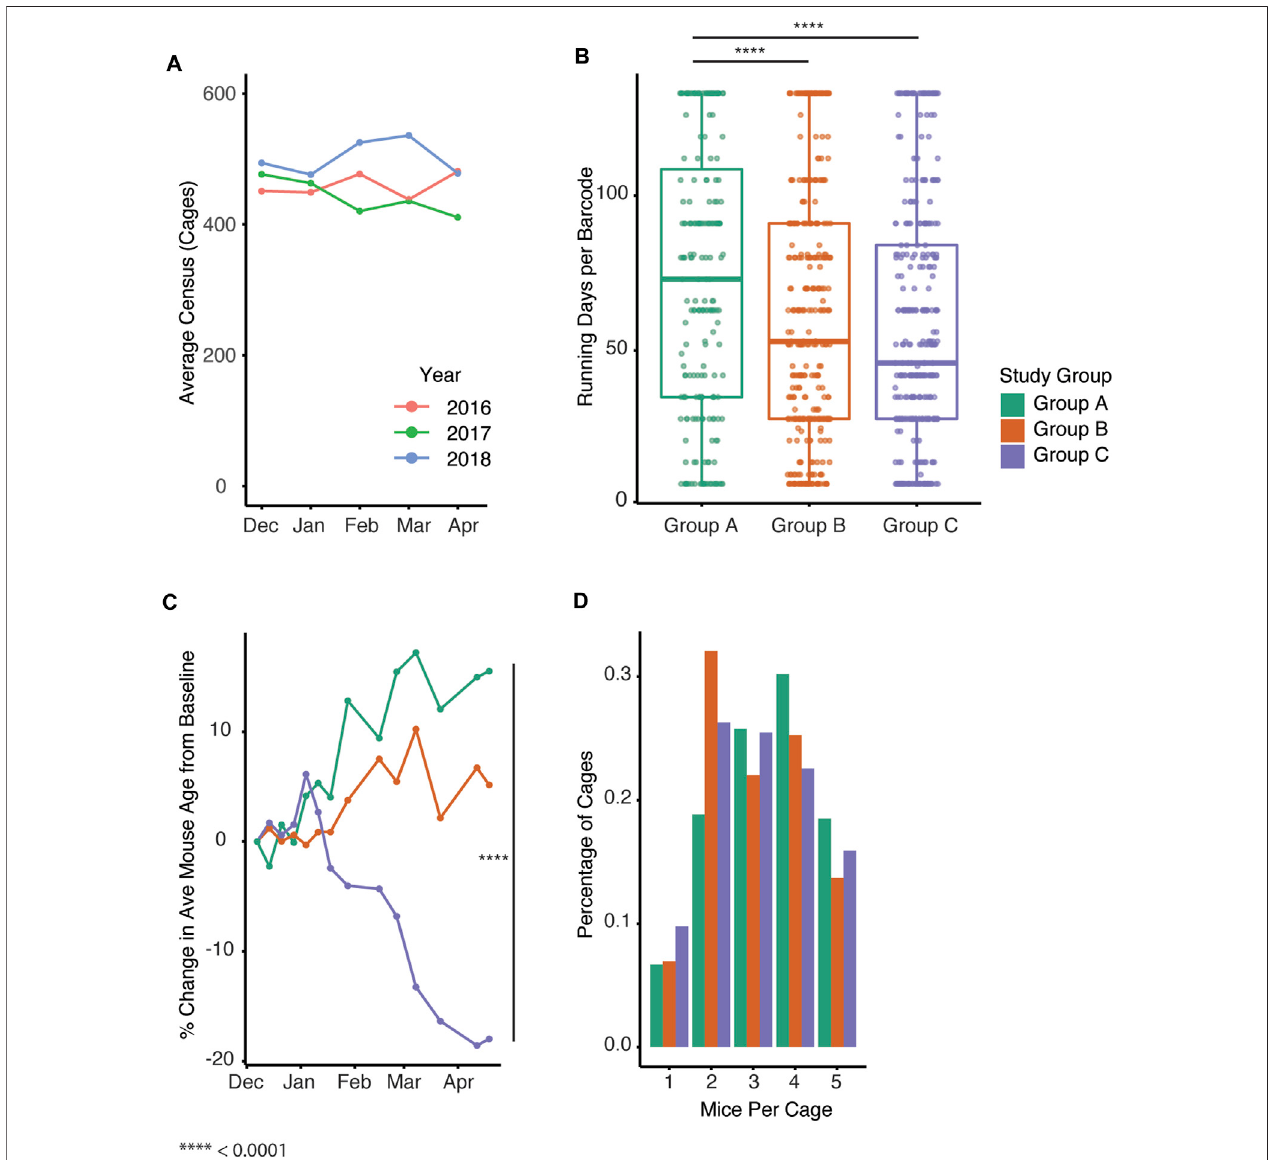
FIGURE4| Automatedgenotyping isassociatedwithincreasedgenerationofnewcages andbreedingperformanceindex. (A) Averagecagecensusforthestudy colony from December through April in past years. (B) Active census days per barcode for all cages in Groups A-C ( p = 1.69 e-06, Tukey post hoc test, p = 4.446 e − 4, 1.0 e − 6, A vs. B, A vs.C) (C) Percent change in average mouse age from baseline over time for Groups A-C ( p = 4.99 e − 06, 0.0617. Group (B, C) (D) Distribution of number of mice per cage for each of the groups (Mixed effect linear regression, p = 1.35 e − 09, 1.92 e − 10, Group B, C).